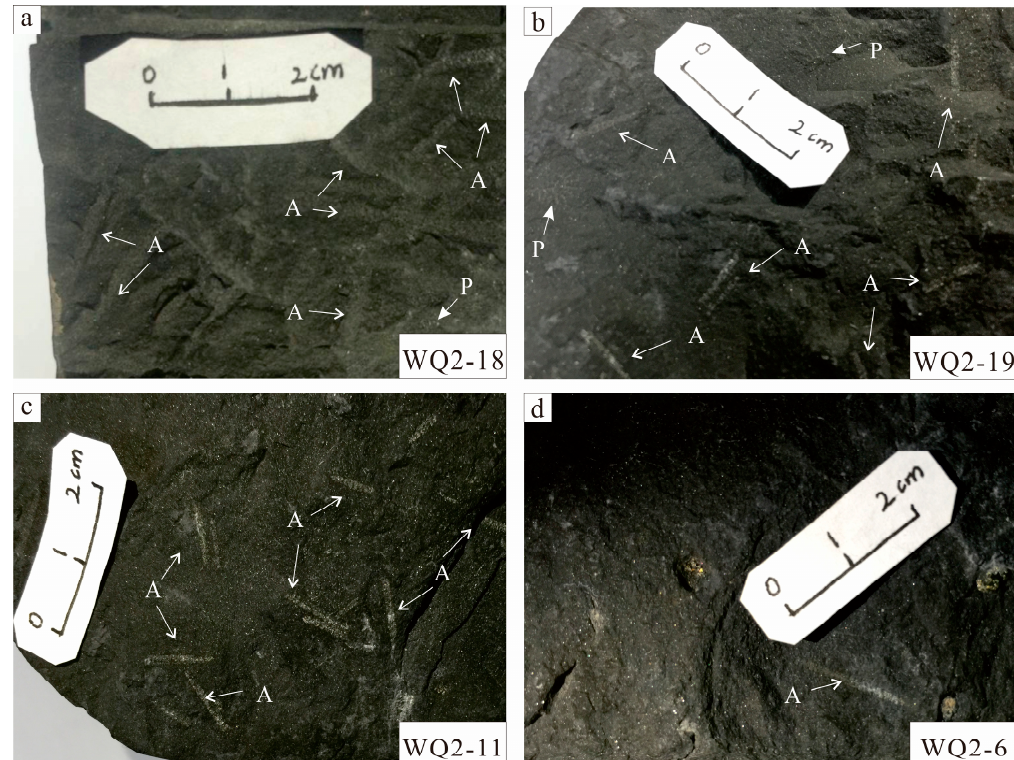
Figure 4. Graptolites of Pastrites (P) and Akidograptus (A) in the collected cores. ( a , b ) Graptolites are randomly oriented in shales and dominated by Akidograptus and a few Pastrites; ( c ) Only a few Akidograptus exist; ( d ) Very few graptolites can be observed.